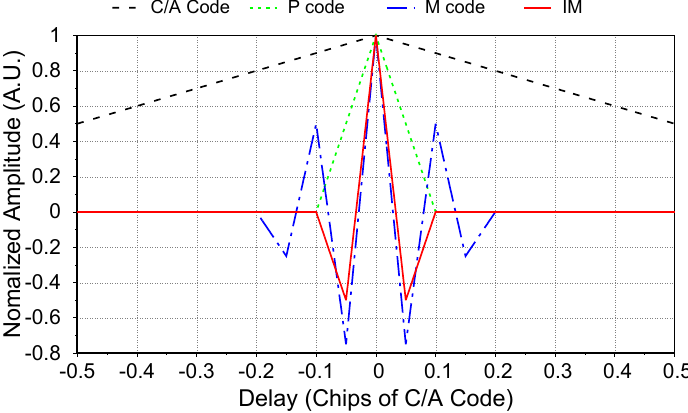
Figure 2. Comparison between the auto-correlation functions (ACFs) for different signal components in GPS L1 band, i.e., the C/A code, P code, M code and Inter-Modulation (IM)